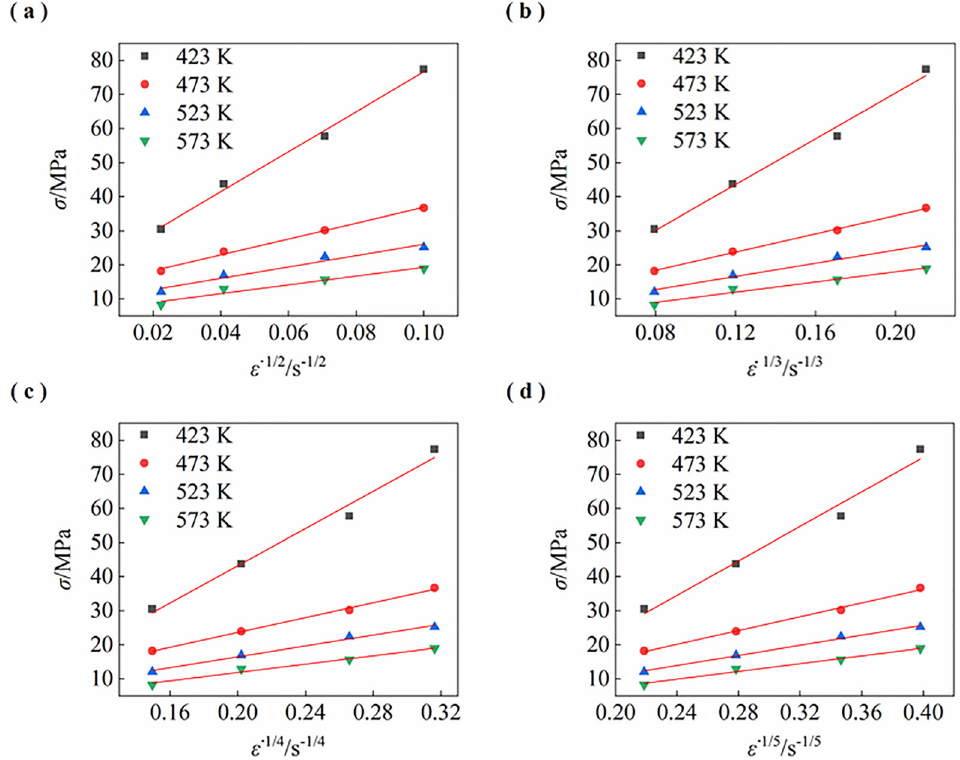
Figure 7. The linear fitting of σ — . ε 1/ n relation in this alloy: ( a ) n = 2; ( b ) n = 3; ( c ) n = 4; ( d ) n = 5.